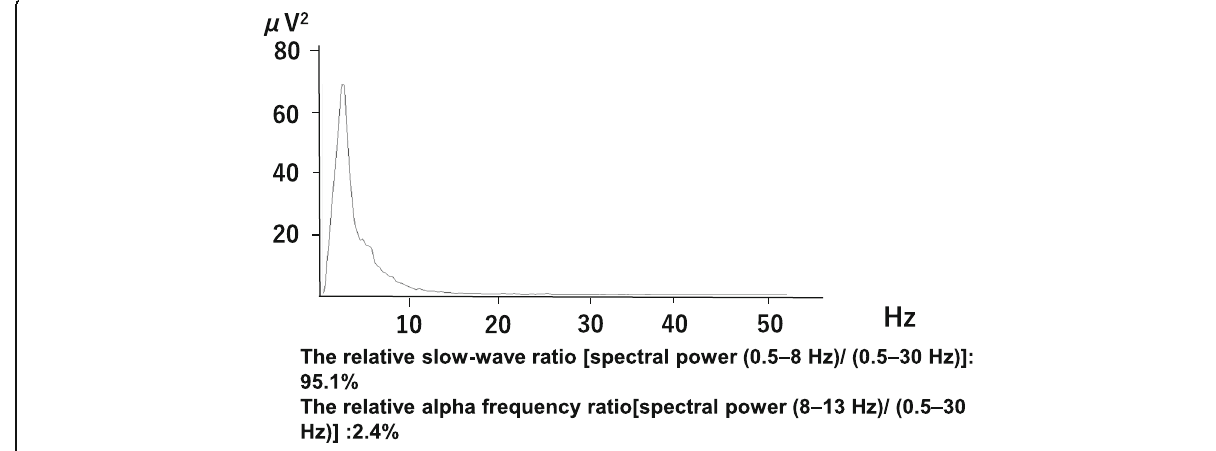
Fig. 3 A frequency analysis for the EEG from anesthetic induction to end of surgery. A frequency analysis for the EEG from anesthetic induction to end of surgery is shown. The relative slow-wave ratio [spectral power (0.5 – 8 Hz)/spectral power (0.5 – 30 Hz)] from before anesthesia induction to the end of surgery was 95.1%, whereas the relative alpha frequency ratio [spectral power (8 – 13 Hz)/spectral power (0.5 – 30 Hz)] was only